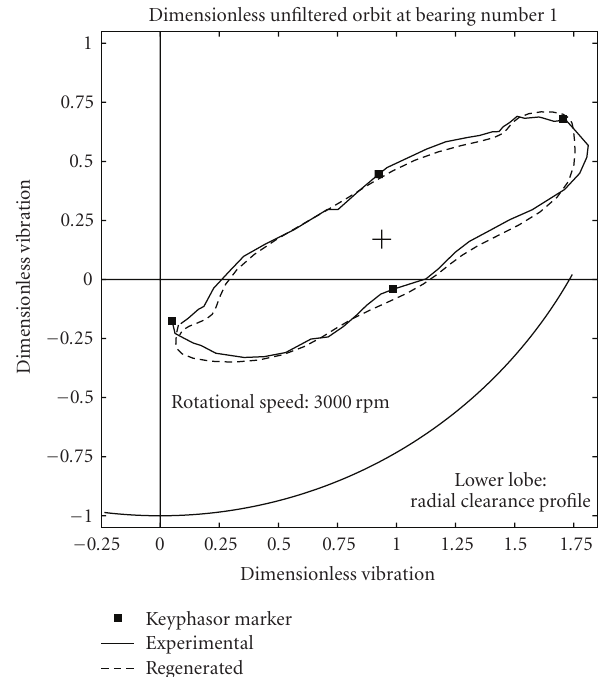
Figure 5: Dimensionless journal orbit measured at bearing no. 1 during an instability